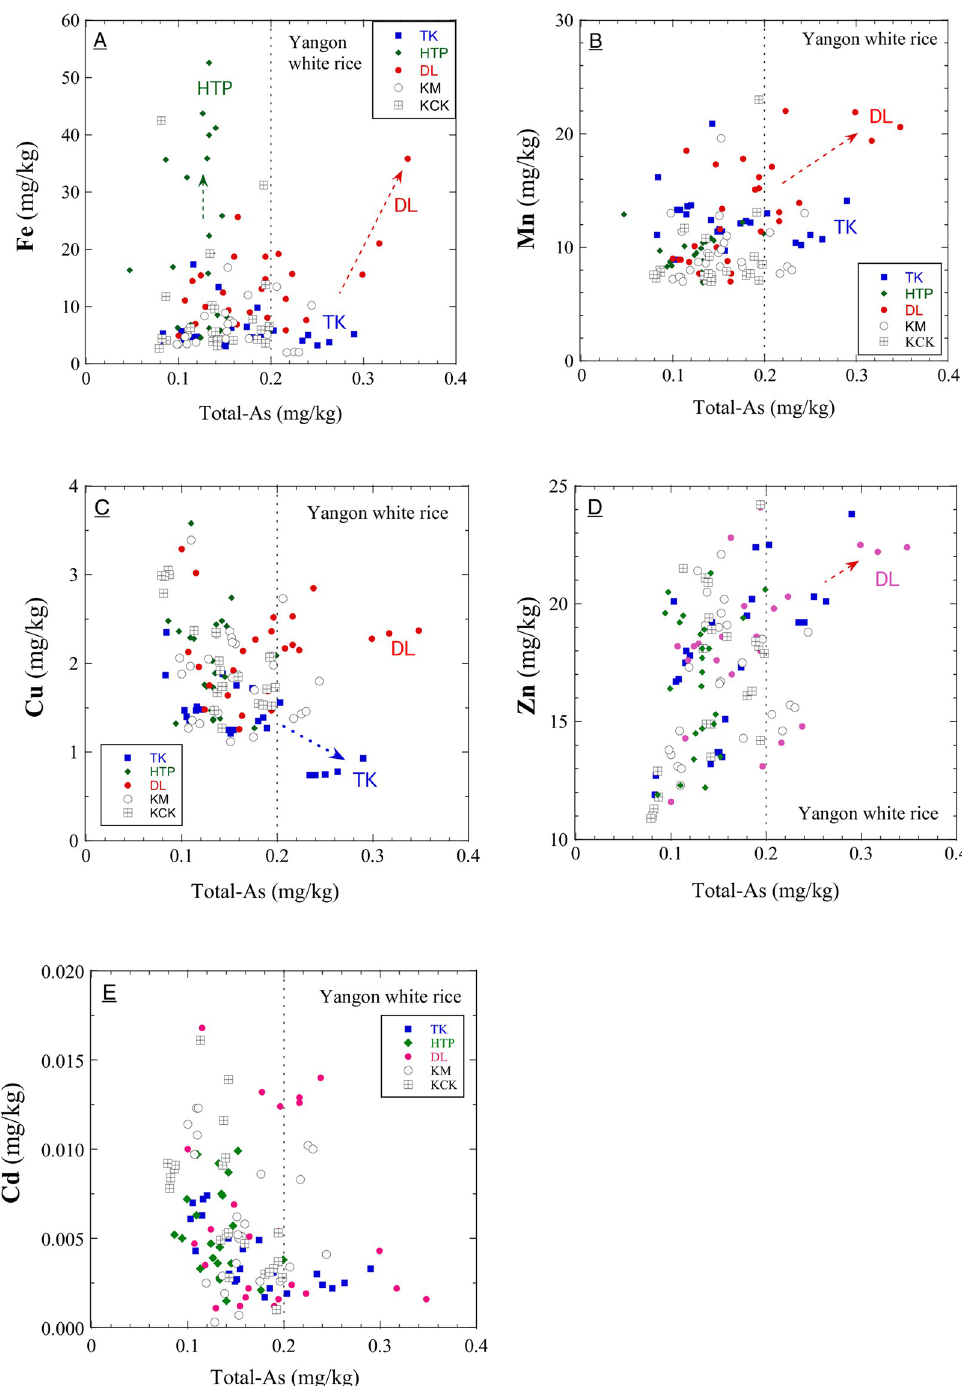
Fig 3. Elemental correlation with total-As contents in white rice grain. A) Fe; B) Mn; C) Cu; D) Zn; E) Cd concentrations in the grains of this study.